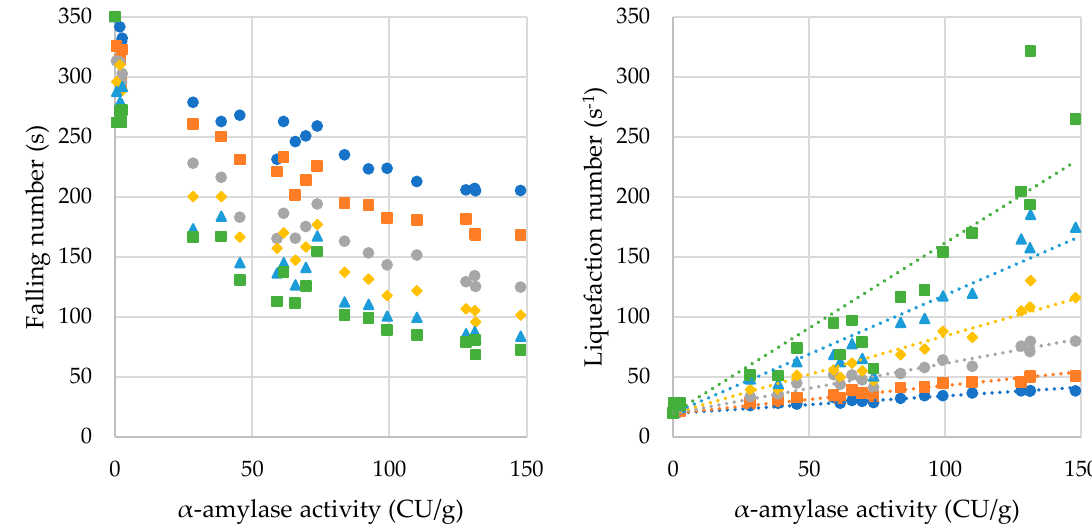
Figure 2. Influence of the addition of different amounts of malt extract on the Falling Number and Figure 2. In fl uence of the addition of di ff erent amounts of malt extract on the Falling Number and Liquefaction Number (lines indicate a linear Liquefaction Number (lines indicate a linear trend).